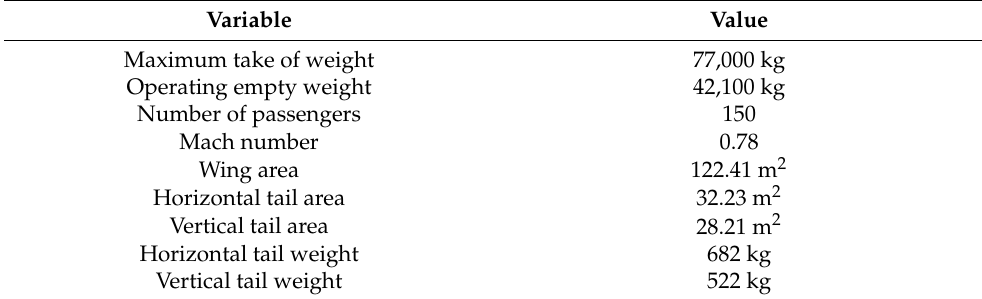
Table 1. CSR-01 parameters available on CeRAS database.